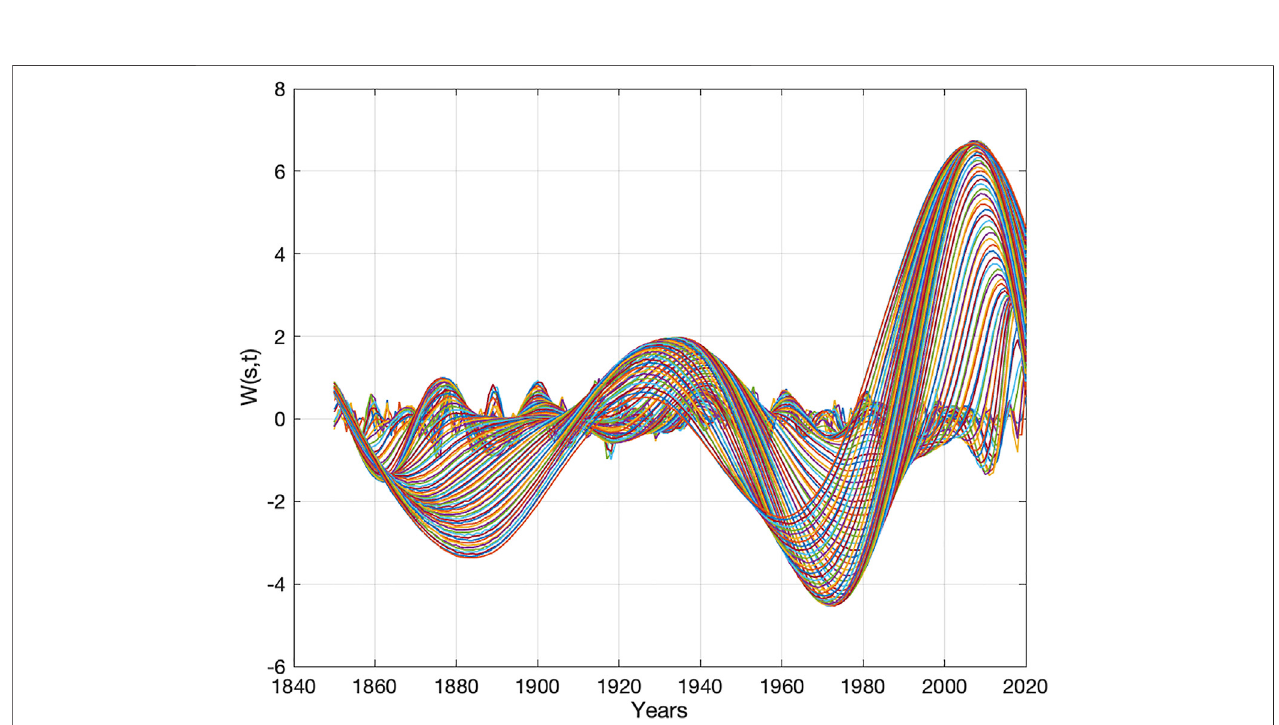
FIGURE 5 | Global mean land temperature wavelet spectrum, Wglt (s, t), for s = (1 ... 85) and t = (1850 ... 2020) (yr.).